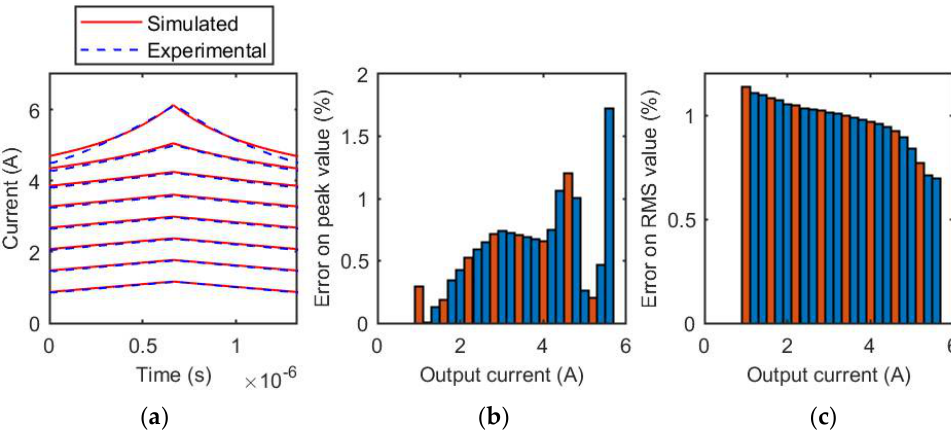
Figure 8. Coilcraft MSS1260T-273 inductor, 750 kHz. ( a ) Comparison of experimental and simulated current waveforms for different output current values; ( b ) relative error of the estimation of the peak value of the inductive current for each tested output current values. The orange bars represent the test cases reported in ( a ), the blue bars are related to the other measurements of the evaluated current range; ( c ) relative error of the estimation of the RMS value of the inductive current for each tested output current value. The orange bars represent the test cases reported in ( a ), the blue bars are related to the other measurements of the evaluated current range.